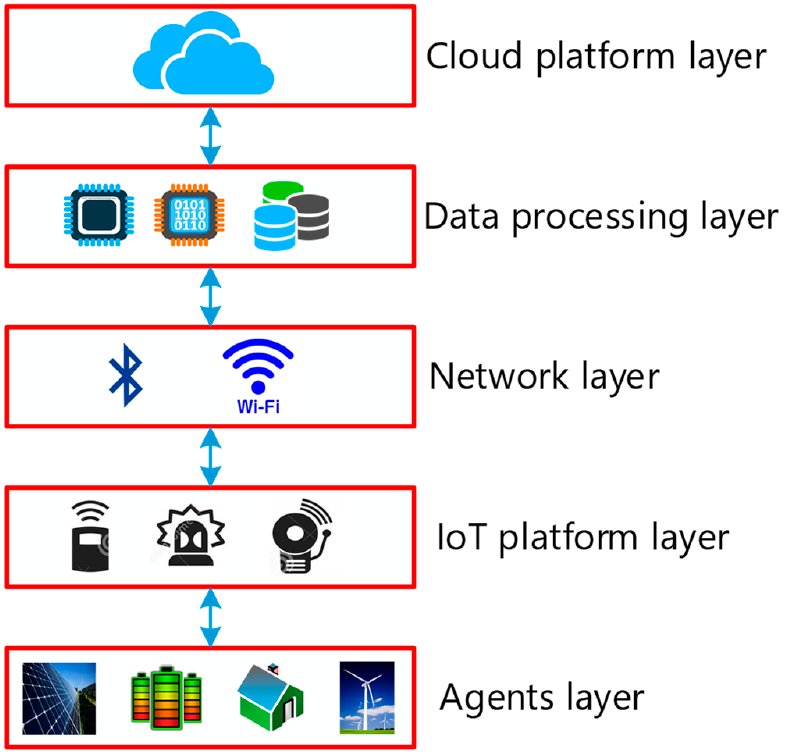
Figure 10. Suggested construction.